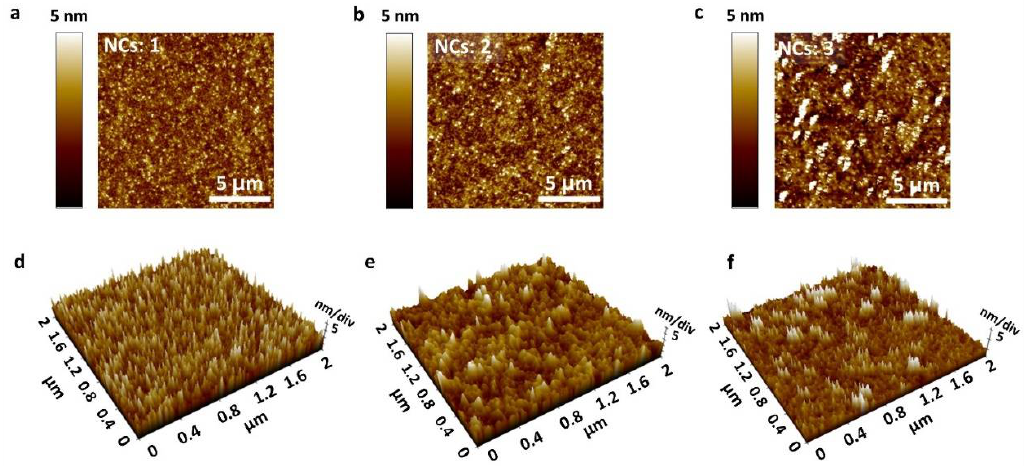
Figure 5. 2D ( a – c ) and 3D ( d – f ) AFM characterization of CTO thin films with different numbers of spin-coating cycles.